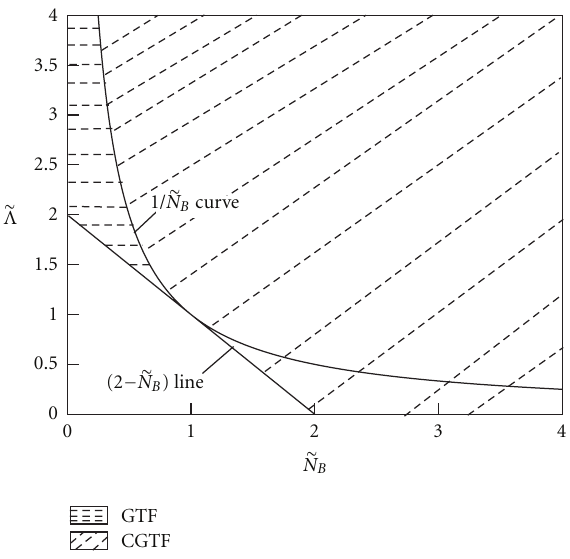
Figure 1: Domain of existence in the ( (cid:2) Λ , (cid:2) N B ) plane of gradient or counter-gradient total turbulent flux at the reactants